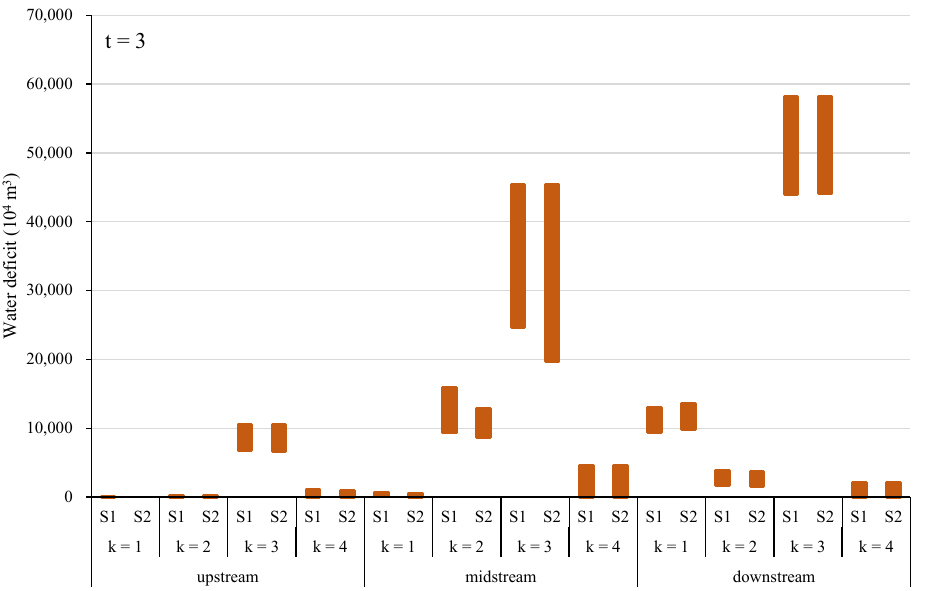
Figure 14. Water resource deficits in the Fenhe River Basin by scenario. Figure 15 shows reused water resources in different scenarios. The water deficits analysis revealed a synergetic change in water resource allocation for the environmental sector. In period 1, the environmental water deficits were [30.31, 395.47] and [67.29, 537.90] × 10 4 m 3 , and the reused water resources were [101.92, 295.54] and [137.90, 438.69] × 10 4 m 3 ; the same values apply to the midstream and downstream areas and other periods. These results could be caused by not considering the benefits of the environment sector and to the strong water demand in this study. Additionally, S2 has a higher reused water rate; thus, the environmental demand in this scenario was supplied by reused water resources.